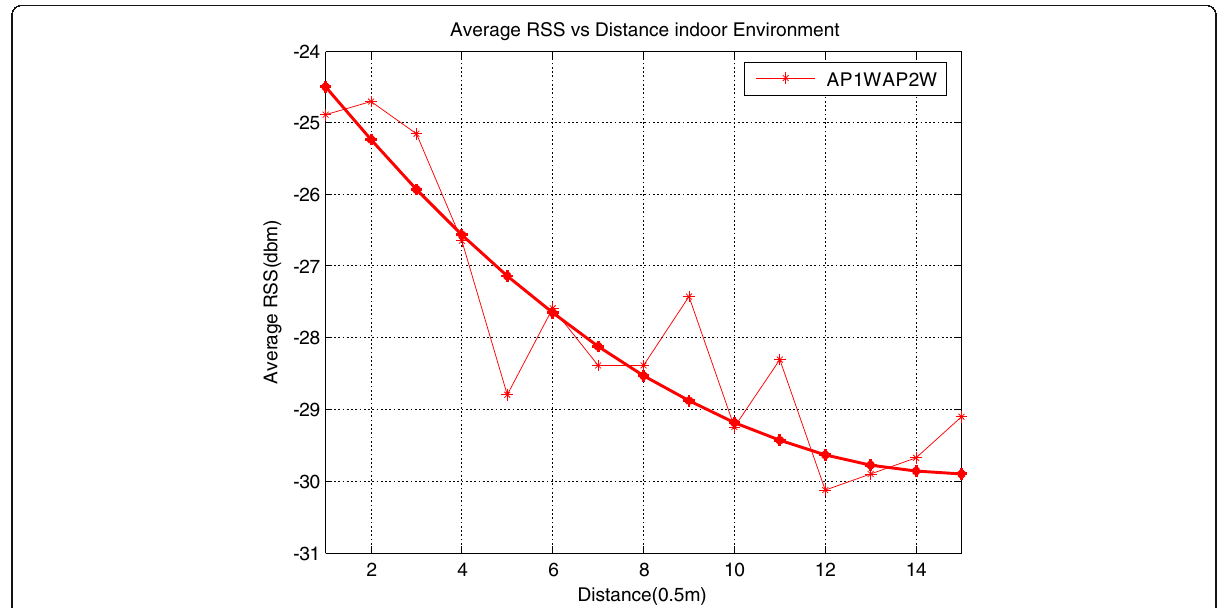
Fig. 8 AP 1 (RSS) and AP 2 (RSS) mean (right). AP 1 and AP 2 RSS signals superimposed change in the same